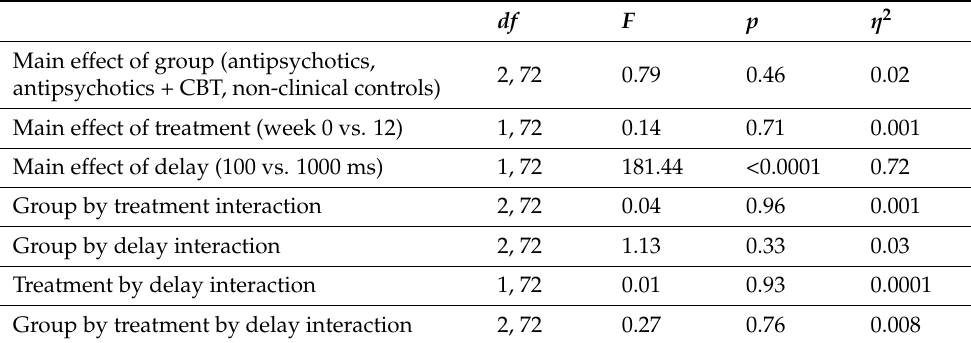
Figure 3. Mean probabilities of making predictions at each delay (100 ms and 1000 ms) at weeks 0 and 12. Error bars indicate 95% confidence intervals. There were no significant differences among the groups. Table 3. Summary of the results from the ANOVA conducted on postdiction scores (probability of making predictions).